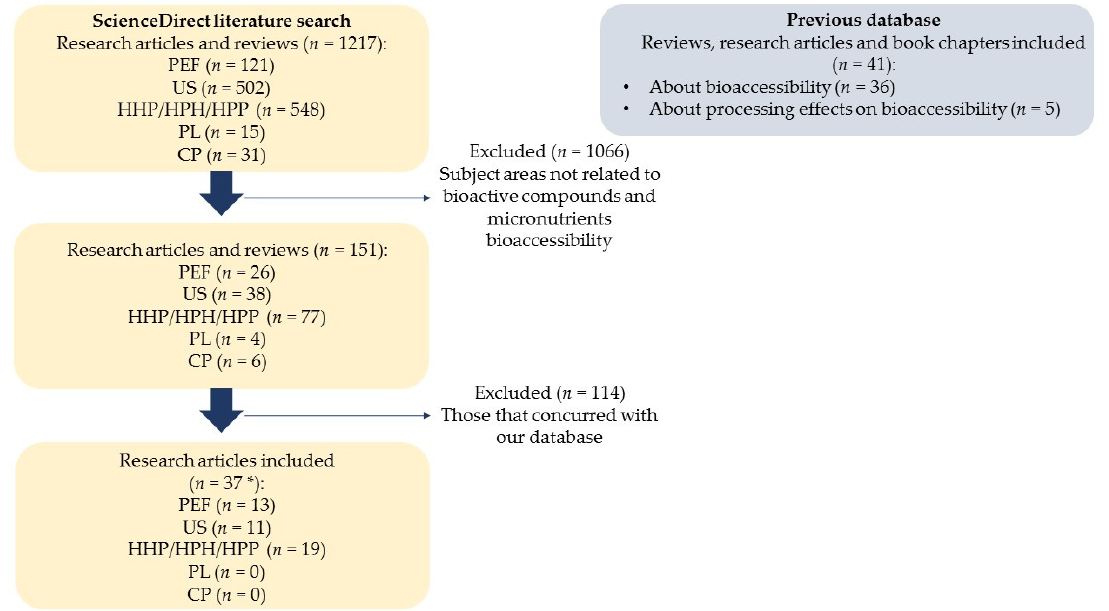
Figure 2. Search criteria for conduction of literature search with keywords “pulsed electric fields” AND “bioaccessibility”, “ultrasounds” AND “bioaccessibility”, “pulsed light” AND “bioaccessibility”, “cold plasma” AND “bioaccessibility”, “high pressure processing” AND “bioaccessibility”, “high hydrostatic pressure” AND “bioaccessibility”, and “high pressure homogenization” AND “bioaccessibility” and excluding results not related to bioactive compounds and micronutrients bioaccessibility. For the review, 78 research documents were referred. * n = 37 because 5 research articles compared in the same manuscript the effect of different processing technologies, therefore those that concurred were removed. CP: Cold plasma; PL: Pulsed light; HHP: High hydrostatic pressure; HPH: High pressure homogenization; HPP: High pressure processing; US: Ultrasounds; PEF: Pulsed electric